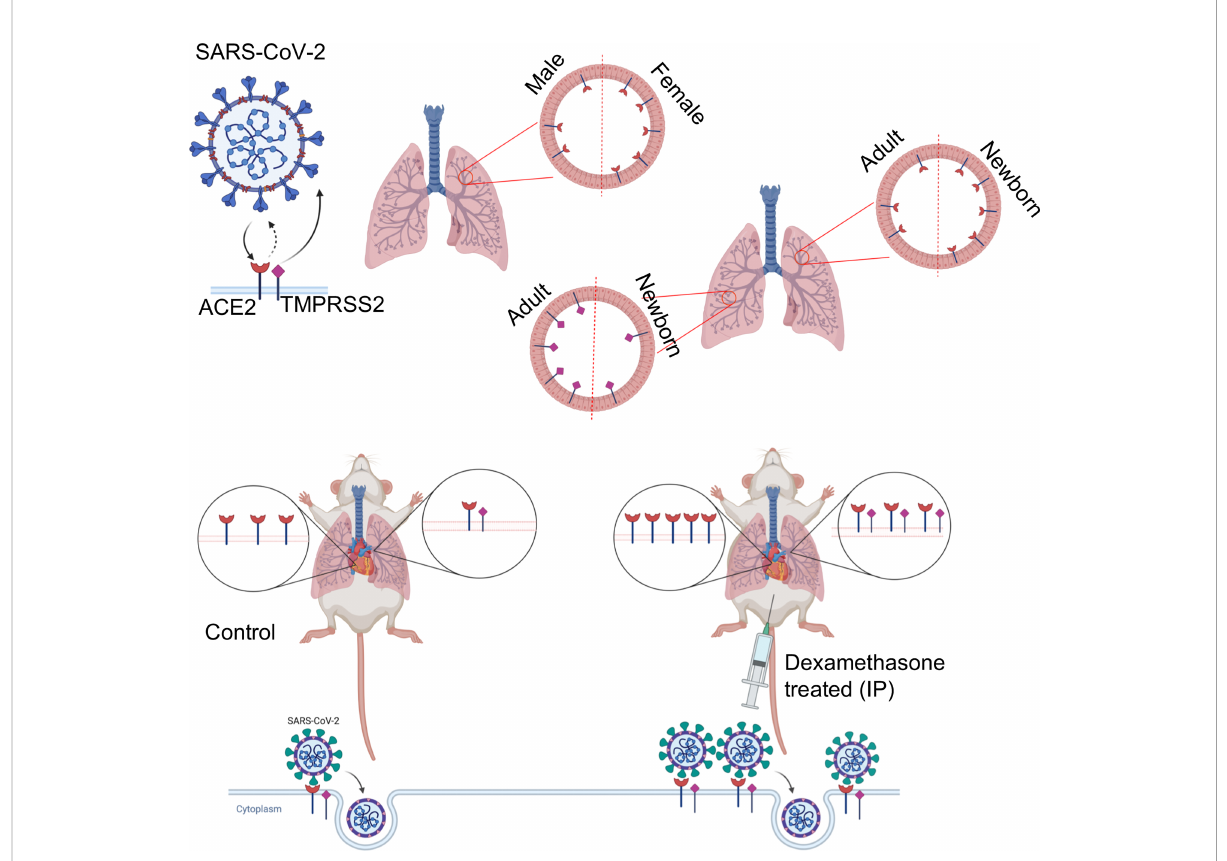
FIGURE 8 The visual summary of the